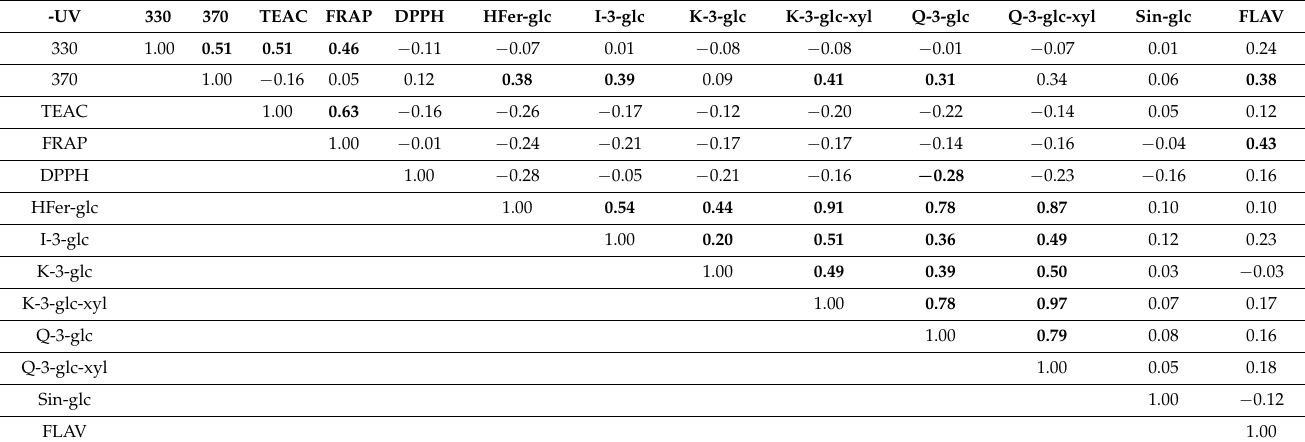
Table 5. Correlation coefficients of UV-absorption at 330 and 370 nm in absorbance per 0.75 cm 2 and antioxidant activity (TEAC, FRAP, and DPPH) in mM Troxolequivalent per g dry matter, soluble flavonoid glycosides and hydroxycinnamic acids in mg per g dry matter, and flavonoid content (FLAV) in relative arbitrary units (Dualex) in -UV plants from Experiment 1 (targeting diurnal rhythm). Bold values represent significant correlations at p ≤ 0.05. I: isorhamnetin; K: